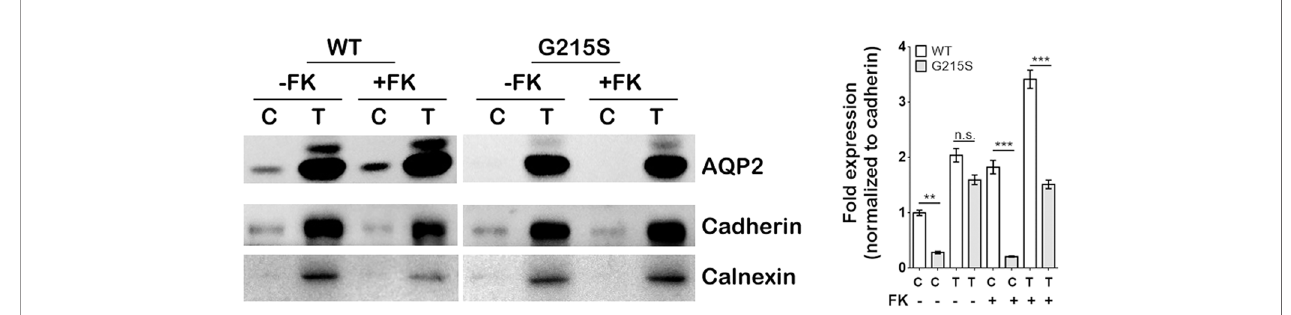
FIGURE 1 | Expression of AQP2-G215S was decreased in the cell membrane compared with AQP2-WT. MDCK cells were transfected with AQP2-WT and AQP2- G215S plasmids. Total membrane proteins (labeled as T) and cytoplasmic membrane proteins (labeled as C) were harvested for AQP2, Pan-cadherin, and calnexin immunoblotting. Pan-Cadherin is the membrane marker, and calnexin is the endoplasmic marker. Protein fold expression normalized to cadherin is shown. WT, wild type; FK, forskolin. Data were shown as mean ± SEM. n = 3, ** p < 0.01, *** p < 0.001, n.s.=no statistically signi fi cant